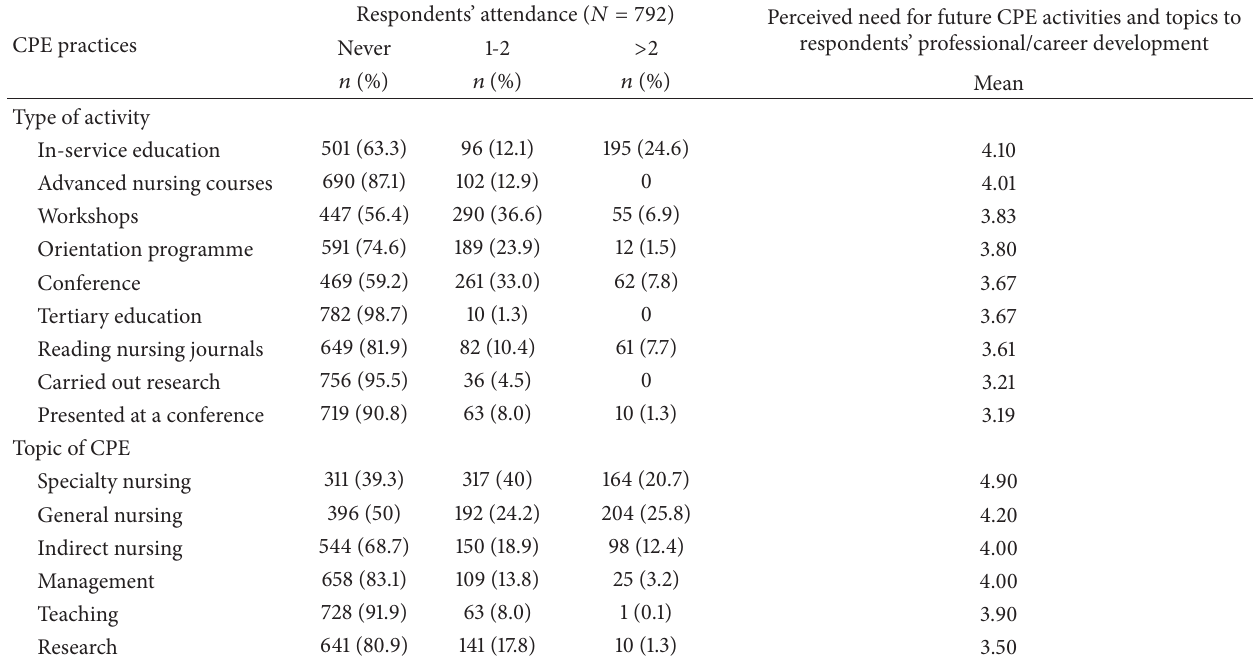
Table 3: CPE practice ( 𝑁 = 792